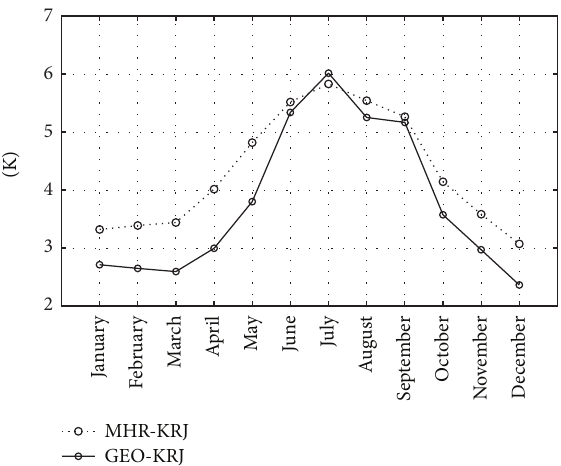
Figure 5: The difference between minimum temperatures of sta- tions MHR and GEO and the rural station KRJ in the period of 1991– 2009.